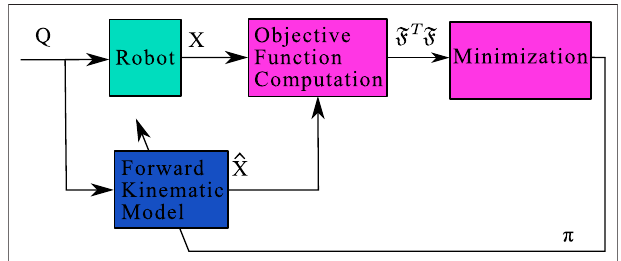
FIGURE 7 | Block diagram of the identi fi cation principle using the Forward Kinematic Model. Considering a set of joints con fi guration Q , the parameters π of the model are changed such as the residual of the objective function Π is